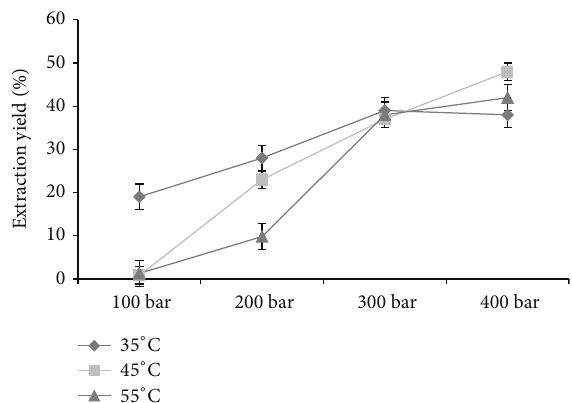
Figure 2: Extraction yield of argan oil at different pressures and temperatures. Table 2: Physical properties of argan oil obtained by SFE and Soxhlet extraction. Also appear the properties of commercial oil. SFE